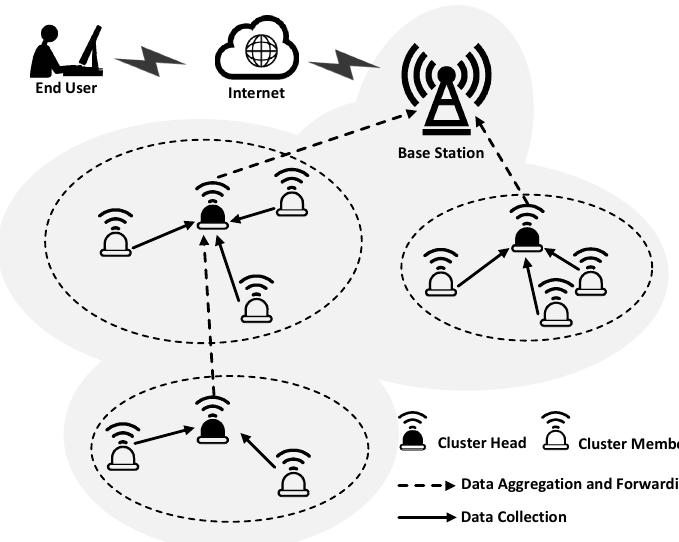
Figure 1. A clustered Wireless Sensor Network.